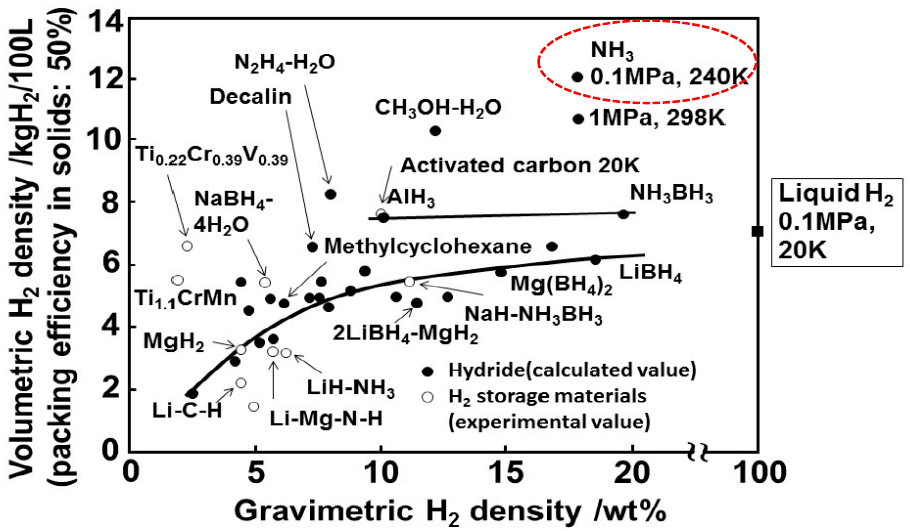
Figure 3. The density of hydrogen in hydrogen carriers